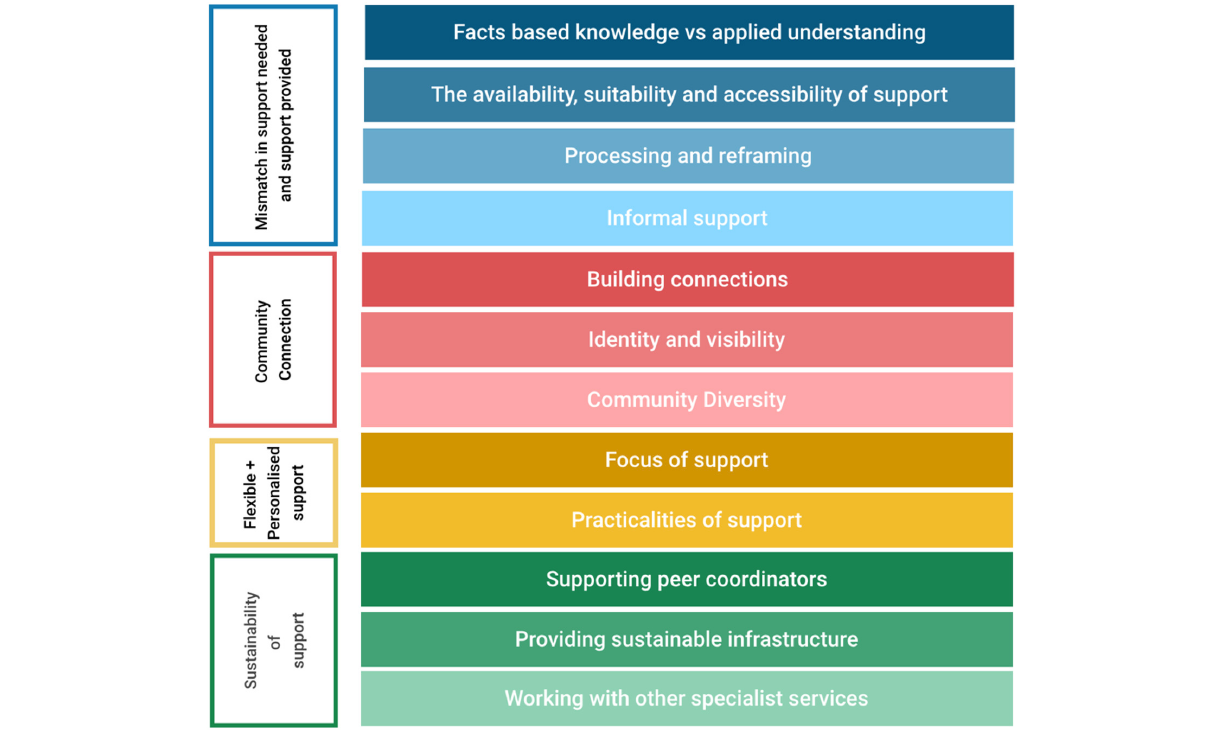
FIGURE 1 | Structure of themes and